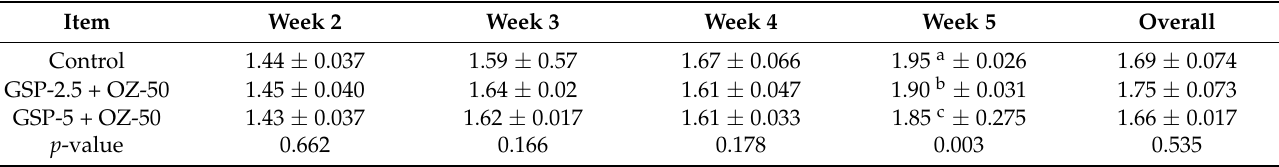
Table 5. Feed conversion ratio (FCR) (g/g ± SE) in broiler chicks fed different levels of zinc-glycine chelate and grape seed powder under summer stress condition.